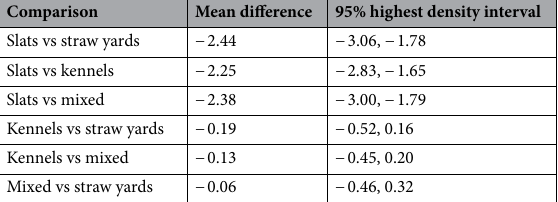
Comparison Mean difference 95% highest density